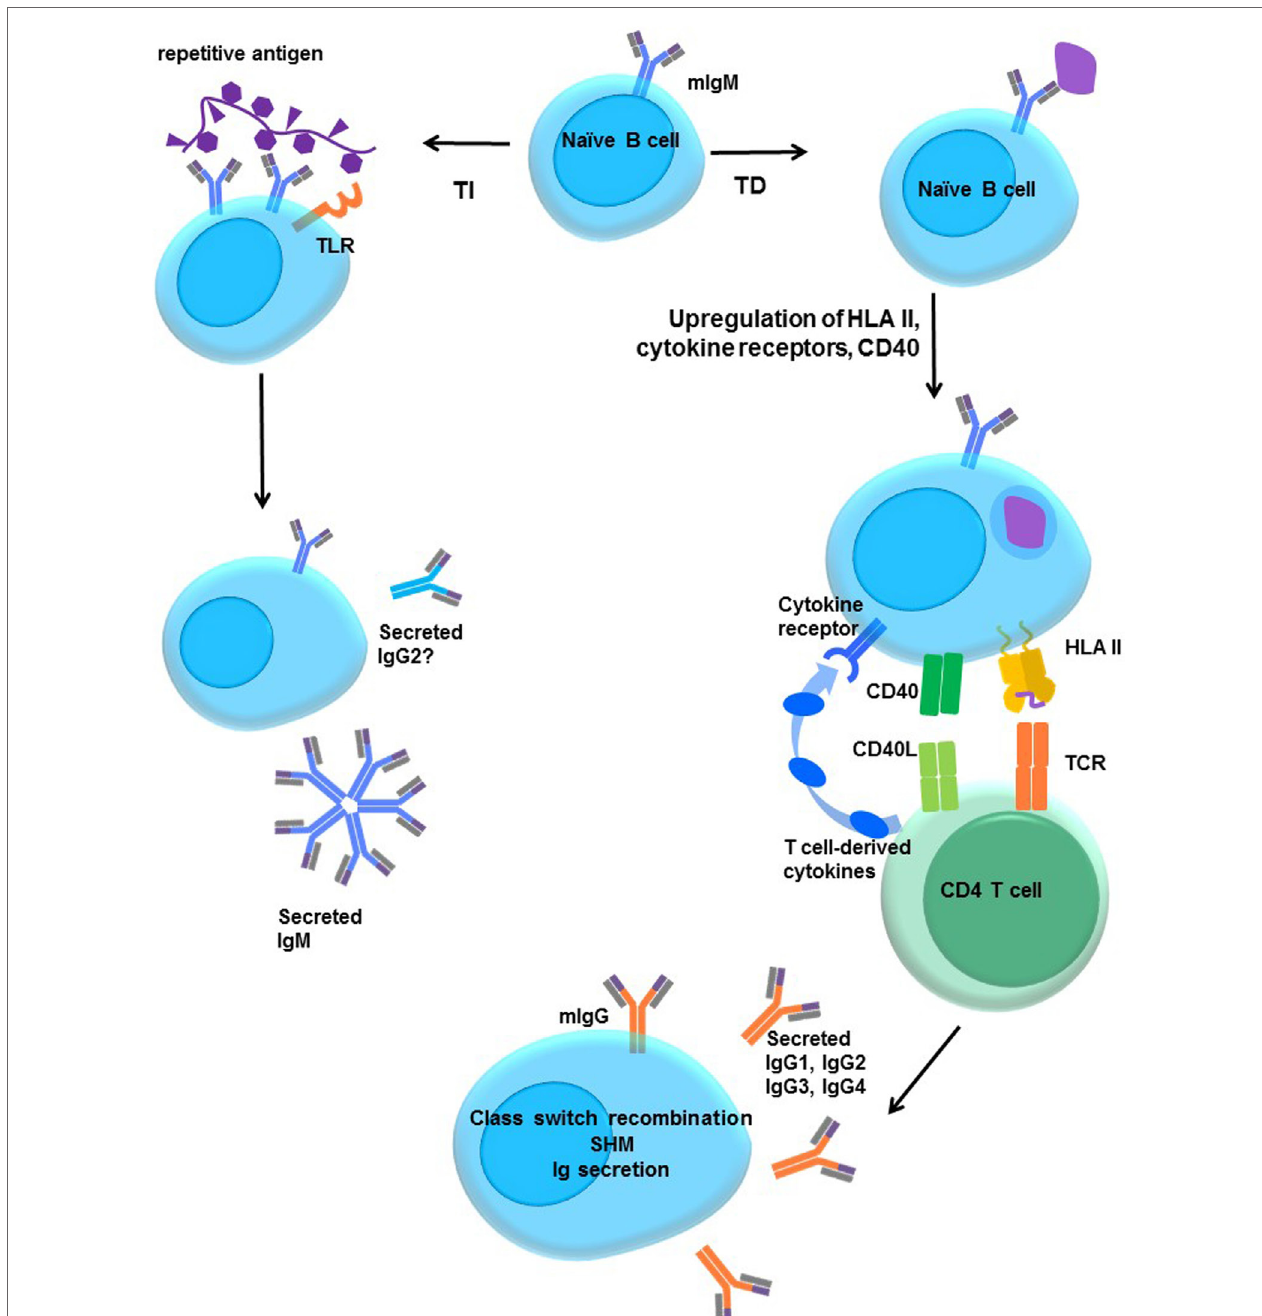
FiGURe 5 | Activation of naïve B cells . Upon encountering cognate antigen through the membrane-associated IgM BCR, engagement of the BCR triggers intracellular signaling. On its own, moderate BCR cross-linking is not sufficient to induce proliferation, but cells do upregulate costimulatory molecules, such as CD40 and B7 (CD80/CD86), and increase antigen processing and presentation. The B cell may internalize the antigen into endosomal vesicles (and downregulates surface IgM), enabling it to process and present the antigen in HLA. B cells upregulate HLA II, cytokine receptors, costimulatory molecules CD40, B7-1, and B7-2, enter the cell cycle, and increase expression of prosurvival genes, and protein translation machinery. T-dependent protein antigens can be internalized and processed into peptides for presentation to CD4 T helper cells in HLA molecules. CD4 T cells provide additional costimulation via CD40L and expression of cytokines, such as IL-21, IL-10, IL-13, or IL-4. Integration of the BCR, CD40, and cytokine signaling stimulates class switch recombination, and the B cell ultimately switches from production of only membrane IgM and IgD to secretion of other isotypes such as IgG. T-independent antigens, such as those with repetitive motifs, extensively cross-link the BCR but are difficult to internalize. Glycolipid or polysaccharide antigens cannot be presented in classical HLA molecules for CD4 + T cell help. Concurrent signals may derive from Toll-like receptor (TLR) stimulation by antigens, NKT or αβ T cell help, leading to enhanced B cell activation and secretion of IgM or IgG2.